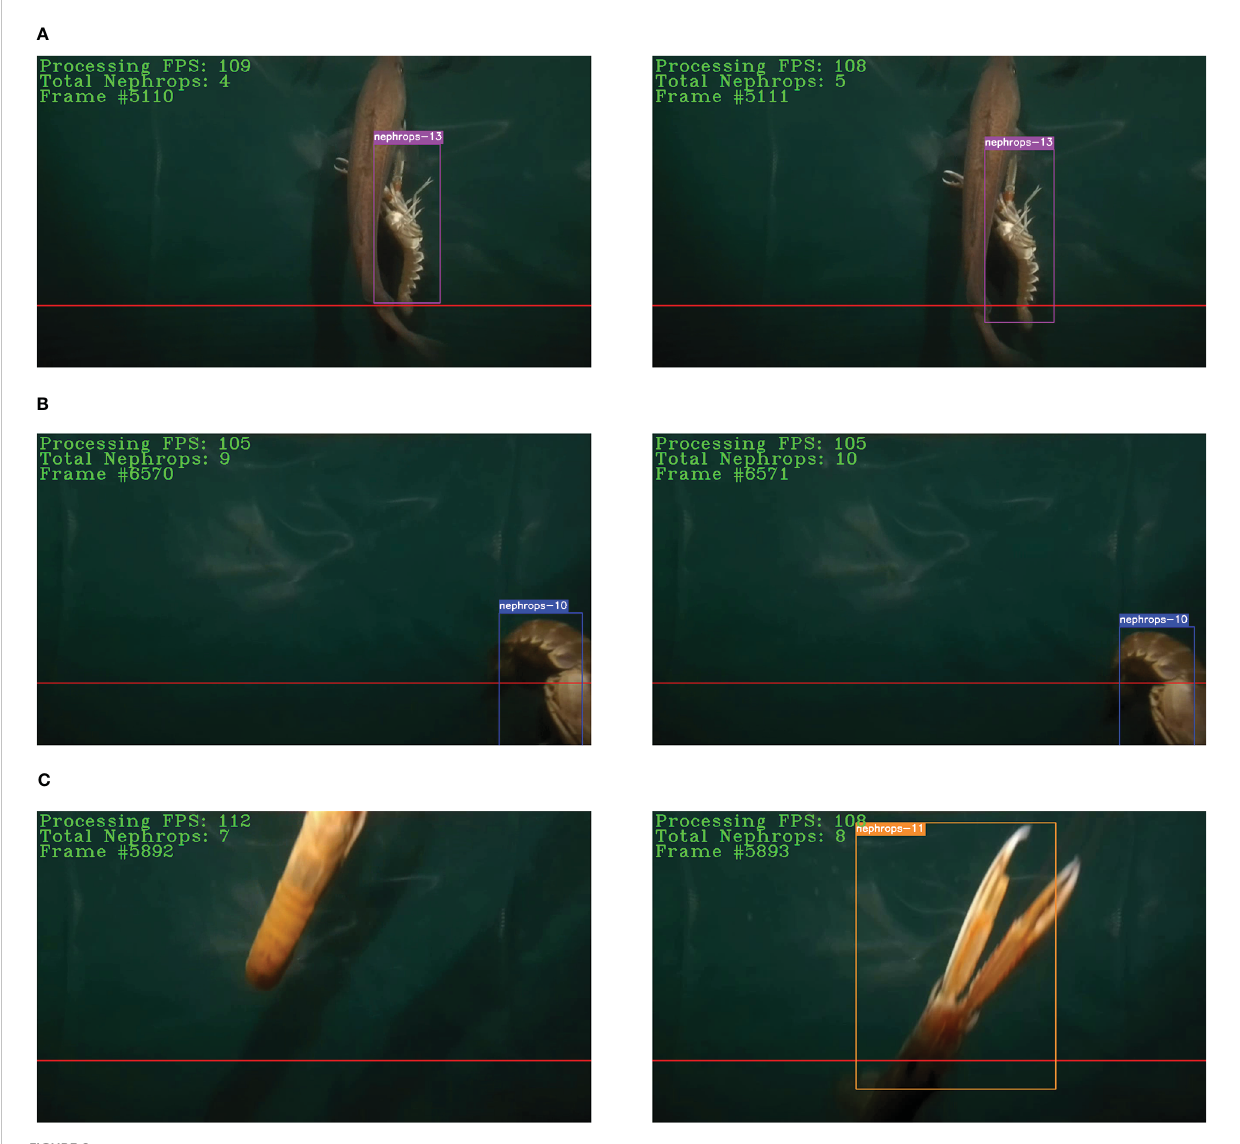
FIGURE 2 Illustration of the counting conditions. Two consecutive frames in the columns. (A – C) correspond to the conditions i, ii, iii , respectively.